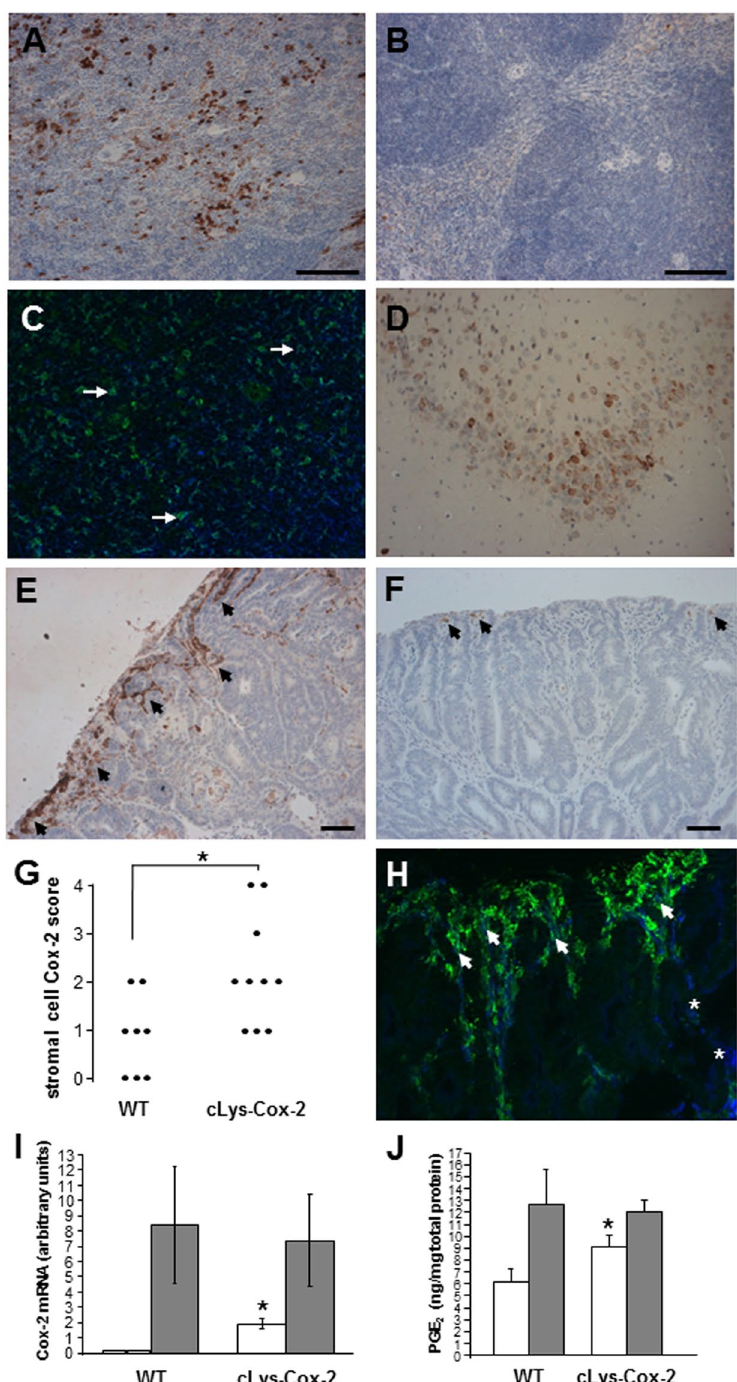
Figure 2. Cox-2 expression in cLys-Cox-2 mouse tissues. Cox-2 immunohistochemistry on ( A ) spleen from a cLys-Cox-2 mouse (day 100) showing Cox-2 protein localisation to transgenic splenocytes unlike ( B ) spleen from an aged-matched WT mouse. ( C ) Dual immunofluorescence for Cox-2 (green) and F4/80 (blue) demonstrating localisation of Cox-2 to splenic macrophages (arrows show examples). Cox-2-positive macrophages represent a subset of the total F4/80-positive splenocyte population. ( D ) Localisation of Cox-2 protein to hippocampal cells in cLys-Cox-2 mouse brain. No Cox-2 protein was detectable in equivalent sections from WT brain (data not shown). Cox-2 protein localization in transgenic cLys-Cox-2 x Apc Min/ + mouse colonic tumours and non-transgenic Apc Min/ + mouse colonic adenomas. ( E ) Strong Cox-2 staining (Cox-2 score 4) in superficial stromal cells (arrows) below the luminal surface of a cLys-Cox-2 x Apc Min/ + mouse colonic tumour. Size bar = 50 μ m. ( F ) Patchy Cox-2-positive superficial stromal cells (arrows) in a non-transgenic Apc Min/ + mouse adenoma (Cox-2 score 1). Size bar = 50 μ m. ( G ) Individual stromal Cox-2 scores of transgenic (n = 10) and non-transgenic (n = 8) Apc Min/ + mouse tumours. * P = 0.02, Mann-Whitney U test. ( H )